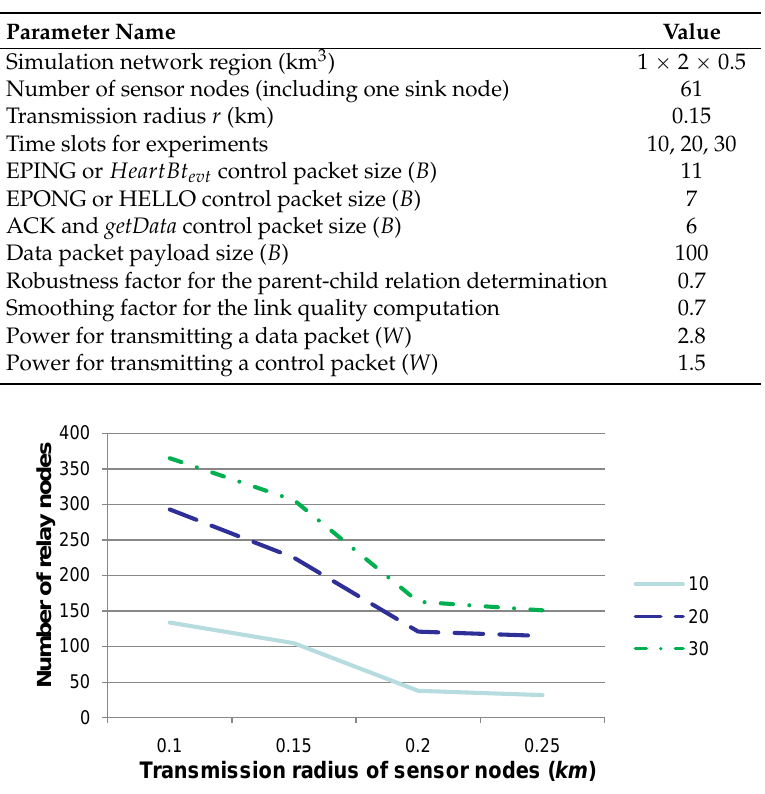
Table 1. Experiential parameters settings.